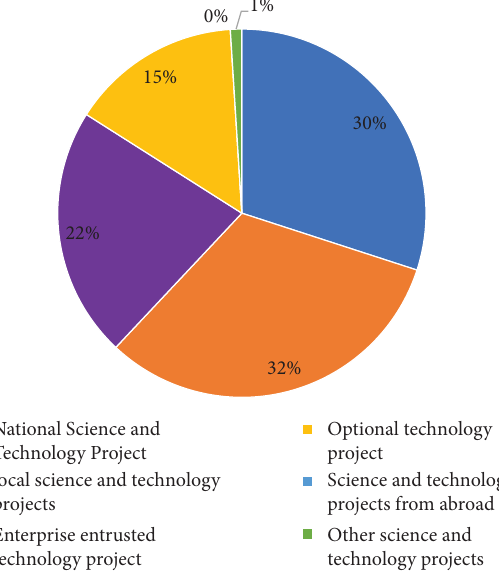
Figure 7: 1017R&D projects in colleges and universities (by source).